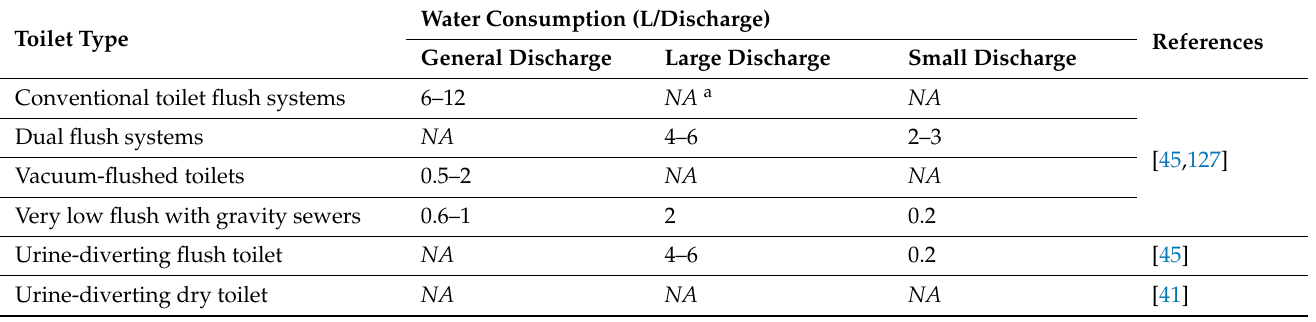
Table A1. Water volume occupied for the discharge of excreta according to the type of toilet used.